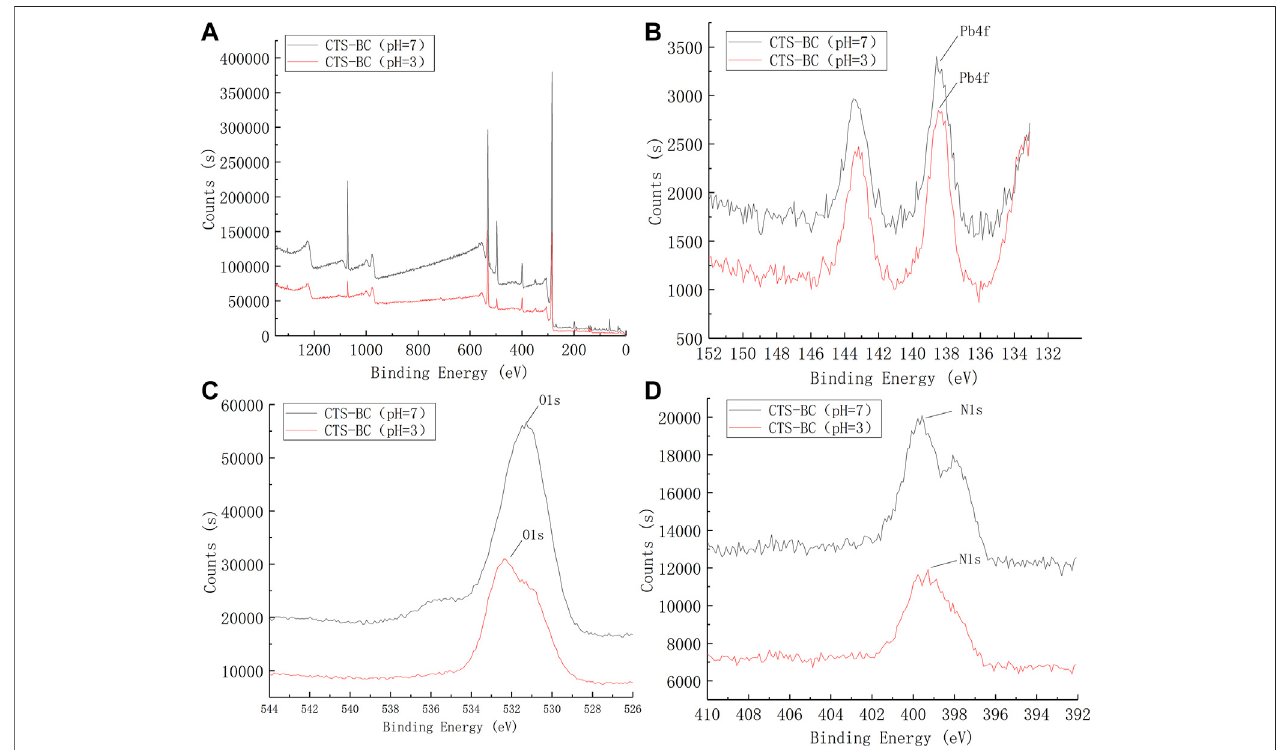
FIGURE 12 | XPS spectrum of CTS-BC. (A) :XPS wide scan of the CTS-BC, (B) Pb4f of CTS-BC, (C) O1s of CTS-BC, (D) N1s of CTS-BC.